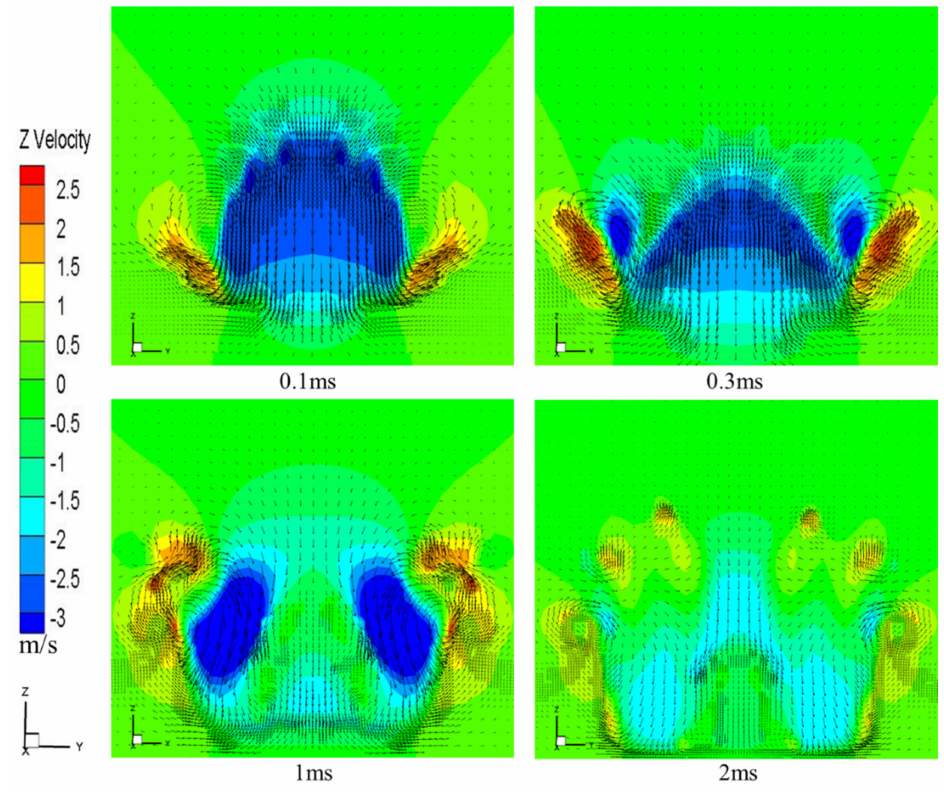
Figure 3. The velocity vector diagrams after a droplet impacts on liquid film at x = 0.01 m section. The liquid film moving in the radial direction is pushed to squeeze the surrounding static liquid film in a very short period of time, which makes the liquid film move upwards, causing the jet source to form in the area around the droplet and the film contact (0.3 ms in Figure 3). As a result, the film thickness in the contact area would become thinner over time, while the film thickness in the outer region would gradually increase. On the other hand, when the fast-moving liquid meets the static film, a kinematic discontinuity would occur at both the velocity and the film height, facilitating the transition from the jet sheet to the formation and propagation of the crown [4]. With the continuous impact of droplets, the energy converted by the inertial force of droplet impact becomes stronger. Compared with 0.3 ms, the velocity of the droplet in contact with the film in the neck region while the velocity at the rim of crown increased (1 ms in Figure 3). When the energy is high enough, splashing will occur (2 ms in Figure